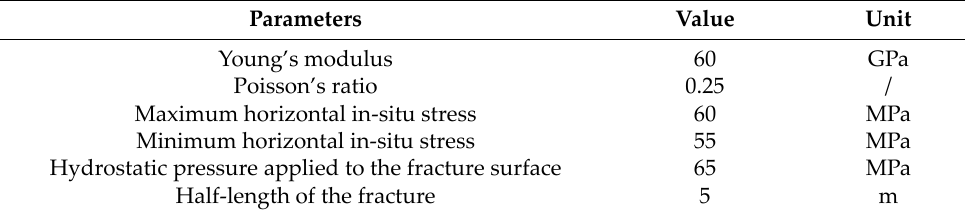
Table 2. Parameters for validation